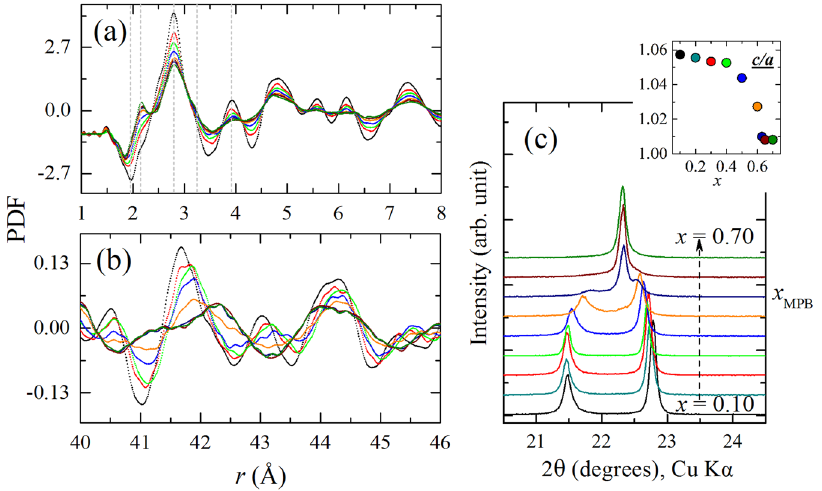
Figure 1. ( a ) Neutron PDFs at ambient conditions in the range 1–8 Å, showing the evolution of short-range atom-atom correlations as a function of composition ( x = 0.10, 0.30, 0.40, 0.50, 0.60, 0.63, 0.65 and 0.70). The colour scheme representing the composition should be followed from ( c ). The negative peak around 1.9 Å is associated with the nearest-neighbour Ti-O distances, whereas the positive peak standing out at 2.1 Å with increasing x corresponds to the first-neighbour Mg-O distances. The peak around 2.8 Å is related to both A-O and O-O nearest-neighbour distances, whereas the shoulder near 3.2 Å refers to first-neighbour A-B distances. First neighbour A-A as well as B-B distances are around 3.9 Å. ( b ) Long-range atomic correlations in the range 40–46 Å, reflecting mainly the changes in the average structure. ( c ) Development of the {001} pc Bragg peak with x from room-temperature XRD data. The composition-induced change in the average structure is apparent: the strong tetragonal splitting diminishes near the MPB, leading to a single peak at x = 0.70. The inset shows the ratio between the unit cell parameters c / a refined in a tetragonal metrics, which is indicative of the average strain of the system. The entire 2 θ range of the laboratory XRD pattern and the x-ray pair distribution functions obtained from synchrotron XRD (APS facility at the Argonne National Laboratory) data as a function of composition can be found in the supplementary information (Figs S2 and